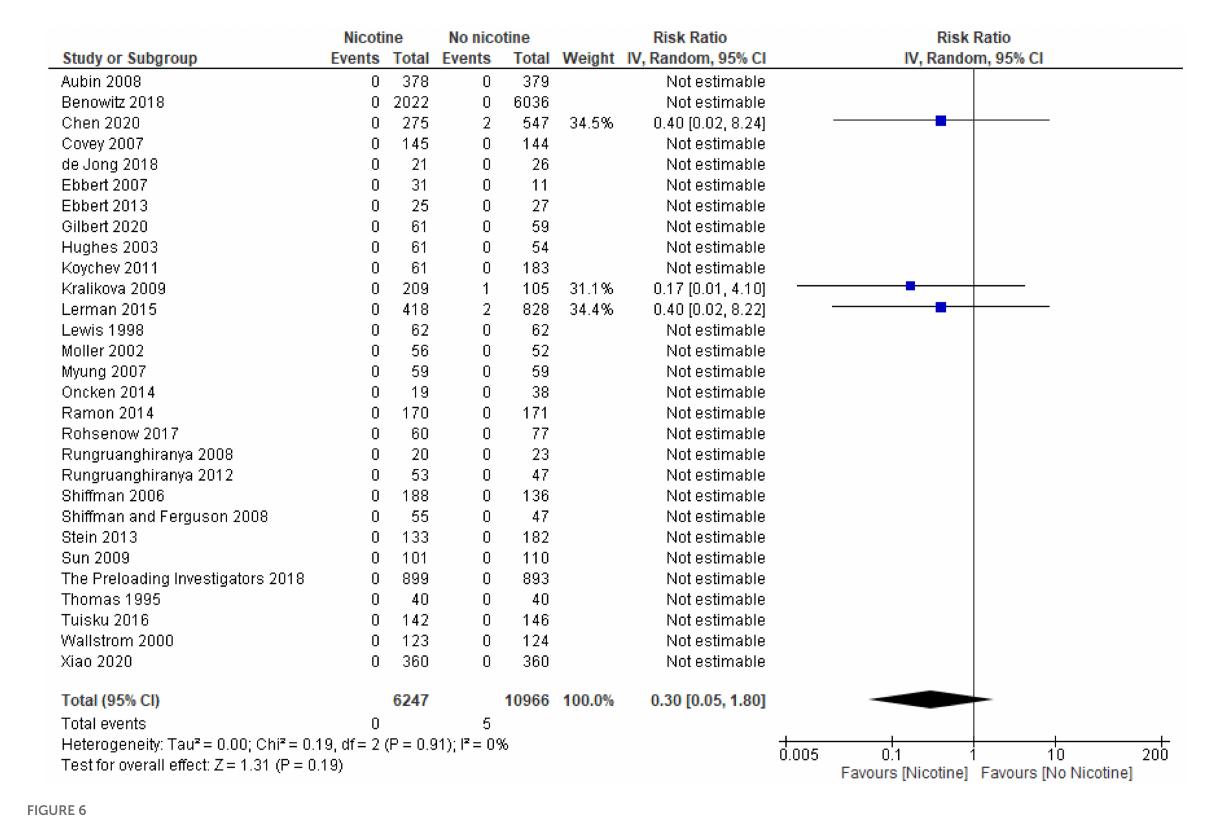
FIGURE 6 Forest plot, meta-analysis for nonfatal